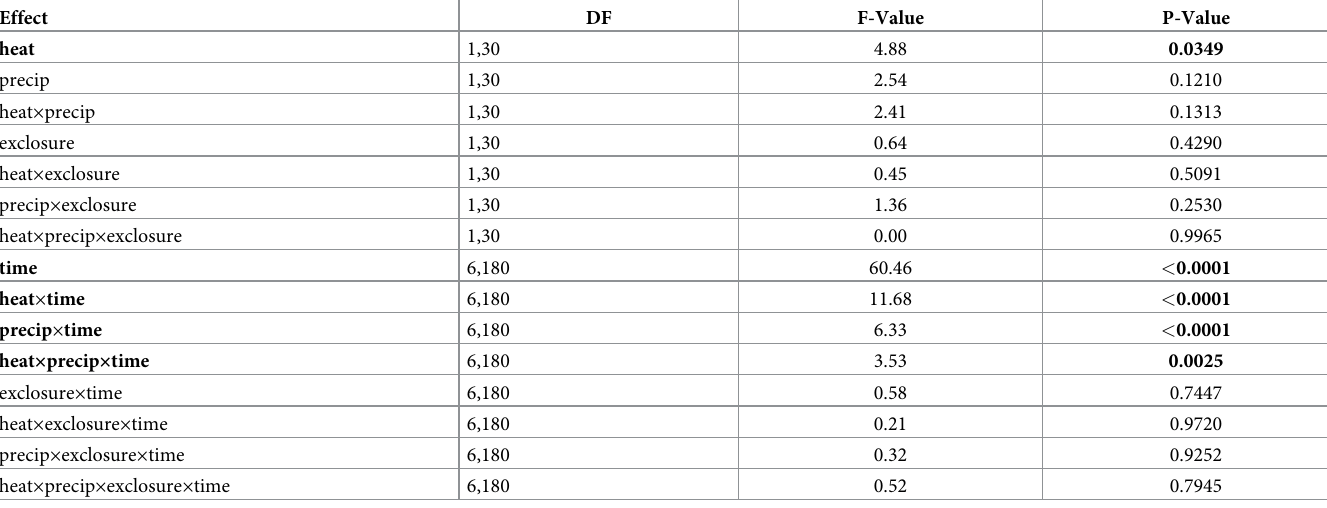
Table 1. ANOVA results illustrating the effect of slug exclusion on aboveground plant biomass within the climate treatment plots over time. Degrees of freedom are shown as numerator, denominator. Bolding indicates significant main effects and interactions.